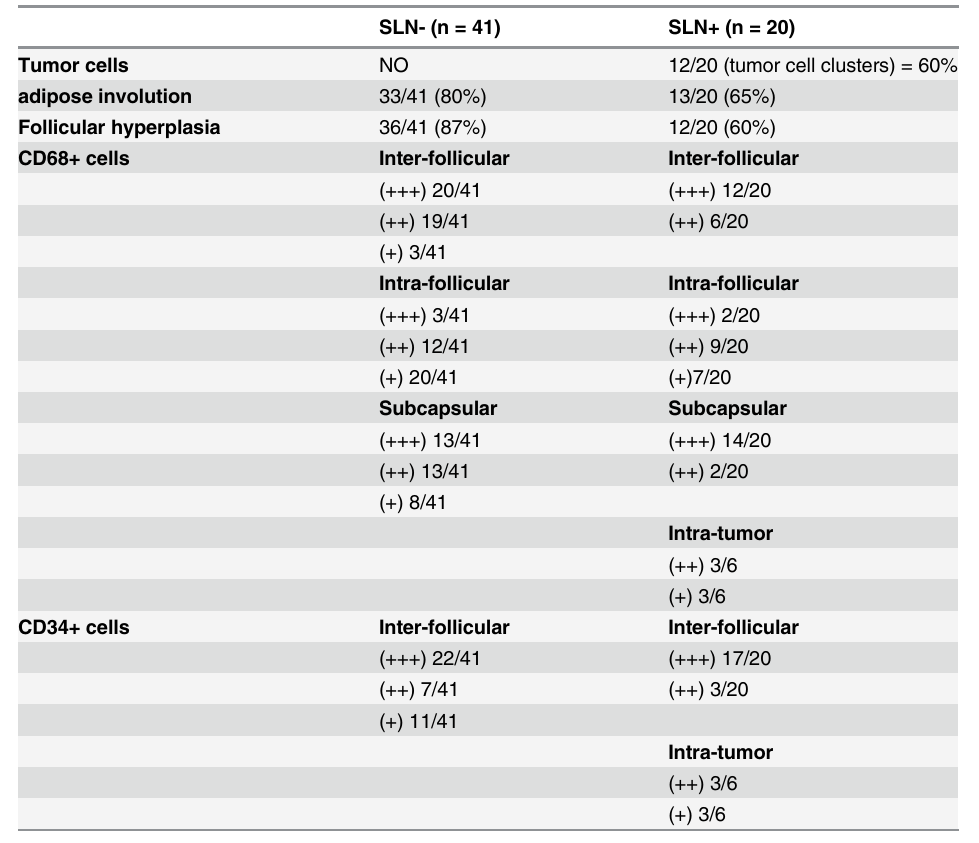
Table 3. Histological characteristics of SLN (HES staining) and distribution and staining density of macrophages (CD68) and endothelial cells (CD34) in SLN - and SLN + in the different areas (inter-, intra- follicular and subcapsular) of the